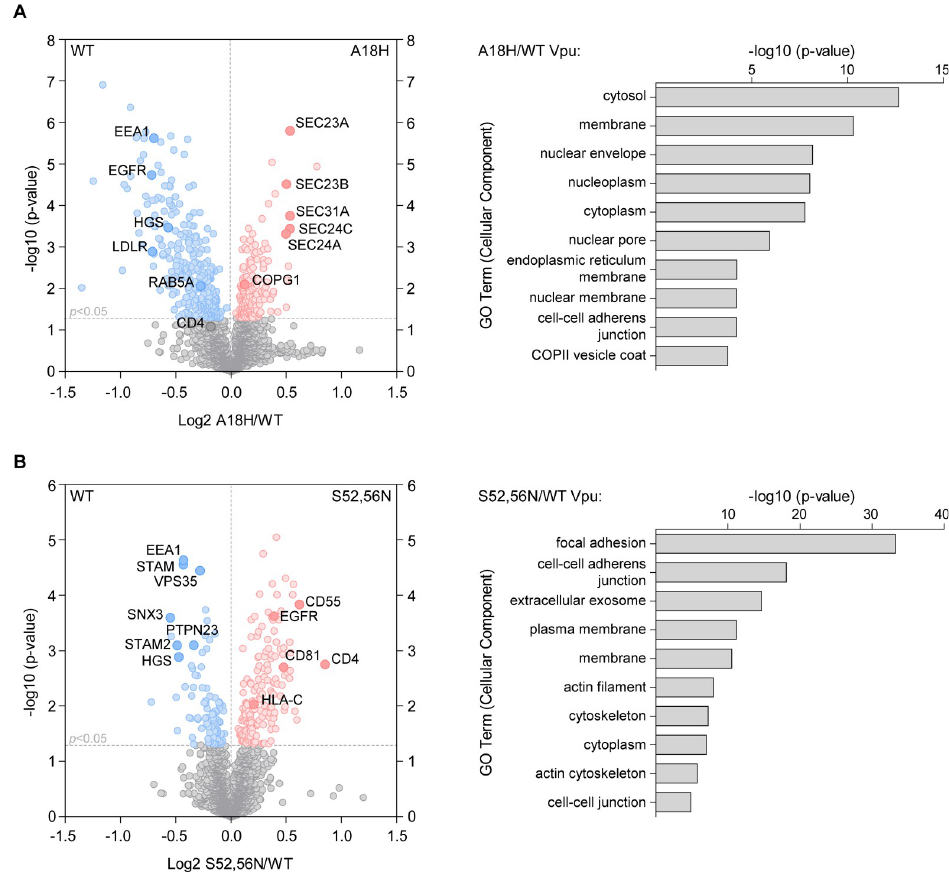
Fig 5. Pair-wise comparisons of the proximity-omes of wild type Vpu relative to the ER-retained Vpu-A18H and the plasma-membrane-enriched Vpu-S52,56N mutants. HeLa P4.R5 cells were transfected to express Vpu constructs bearing C-terminal APEX2 tags, in duplicate. Following proximity biotinylation reactions, the biotinylated proteins were isolated and subject to quantitative mass spectrometry. Volcano plots of protein enrichment in the presence of Vpu mutants A18H or S52,56N relative to the wild-type Vpu are shown, n = 2 experiments. Significantly enriched proteins highlighted in red and blue are derived from the Student’s t -test ( p < 0.05). (A) The A18H mutant was enriched in proteins derived from the biosynthetic pathway, including the ER (labeled), while WT Vpu was enriched for proteins associated with plasma and endosomal membranes (labeled). (B) The S52,56N mutant was enriched in proteins derived from the plasma membrane (labeled), while WT Vpu was again enriched in endosomal sorting proteins (labeled). Proteins enriched by the S52,56N mutation included the known targets CD4, CD81, and HLA-C, and possible targets EGFR and CD55. For both (A) and (B), the x -axis shows log2 fold change of proteins enriched by mutant/WT Vpu and the y -axis -log10 of p -value derived from Student’s t -test. The 10 most highly enriched gene ontology (cellular component) terms are shown on the right of each volcano plot, corresponding to significantly enriched proteins proximal to the mutants; p -value derived from Bonferroni test. K-means clustering analysis was used to partition protein enrichment data from all four conditions (WT Vpu and the three mutants) into groups with similar protein abundance pat- terns (Fig 6A). The 6 resulting protein clusters included potential cofactors (cluster 6, Fig 6B) and targets (cluster 5, Fig 6C) for Vpu activities. Specifically, we reasoned that cluster 5 pro- teins, which were decreased relative to WT when Vpu was retained in the ER by the A18H mutation but increased when Vpu was displaced to the plasma membrane by the S52,56N mutation, would include Vpu targets, especially if degraded by an ERAD-like mechanism. Consistent with this notion, cluster 5 includes known Vpu targets CD4, CD81, and HLA pro- teins. We also reasoned that cluster 6 proteins, which were decreased by both the A18H muta- tion and the S52,56N mutation, would reflect the local intracellular environment of WT Vpu